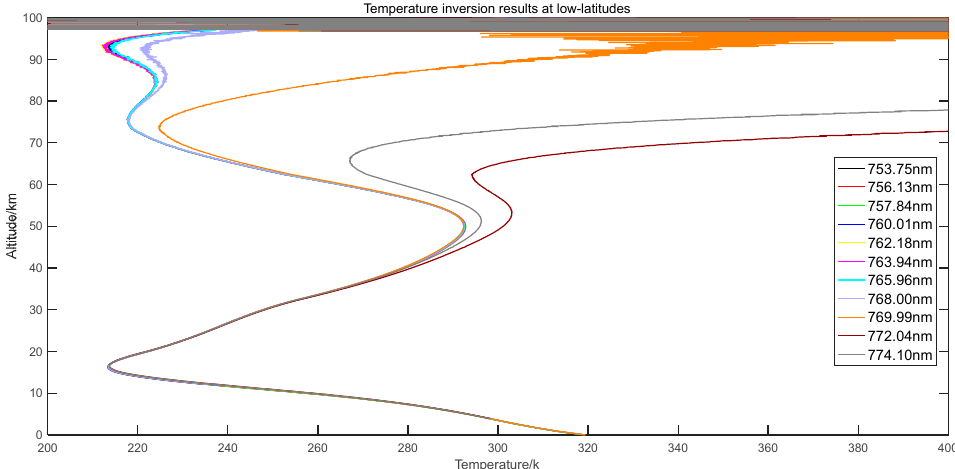
Figure 5. Temperature inversion results at different